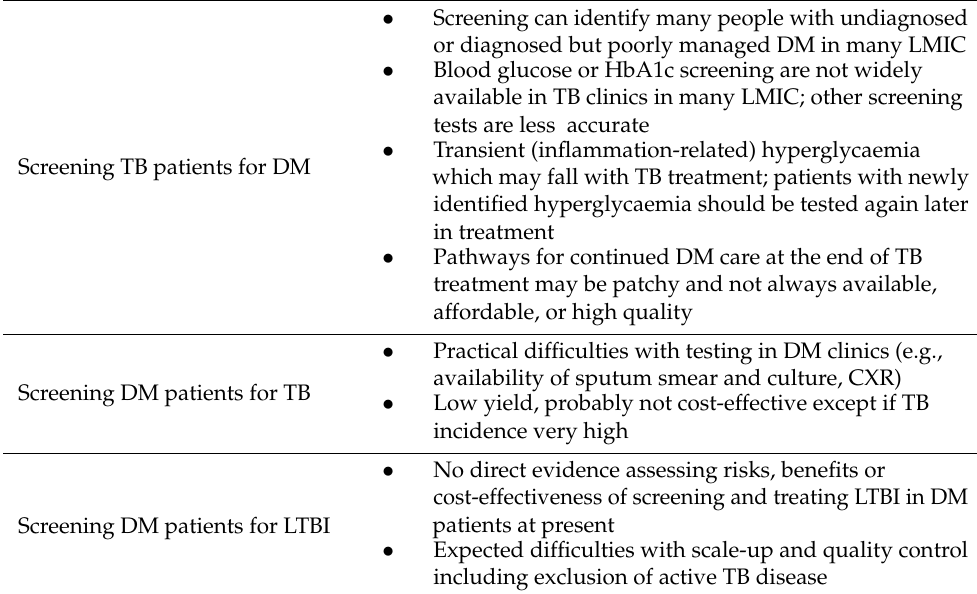
Table 1. Key Issues Related to Screening TB Patients for Diabetes and Diabetes Patients for TB.